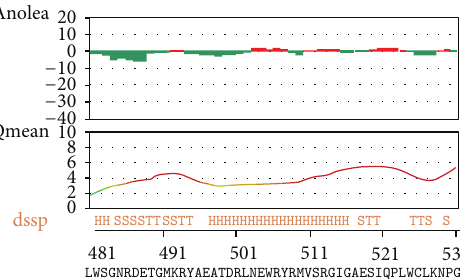
Figure 5: Anolea, Qmean, and DSSP (define secondary structure of protein) obtained from the structural assessment by SWISS-MODEL workplace online